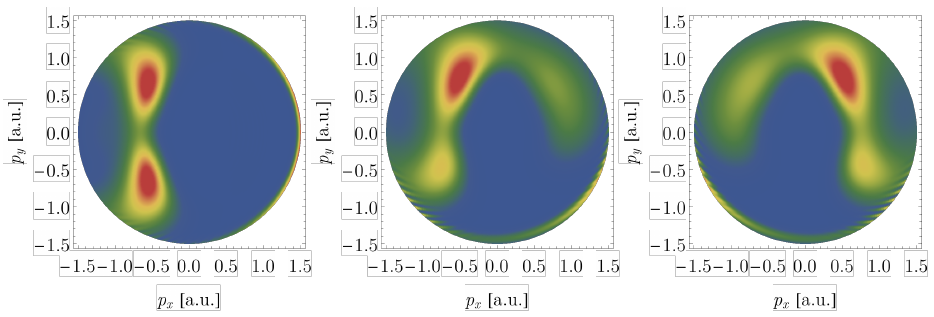
Figure 7. Photoelectron momentum distributions in the polarization plane ( ϑ p = π /2) for a krypton target. Momentum distributions are shown for circularly-polarized laser beams with three different CEP phases: φ ( CEP ) = 0 ◦ ( left panel ), φ ( CEP ) = 45 ◦ ( middle panel ) and φ ( CEP ) = 90 ◦ ( right panel ) and by applying a self-consistent initial 4 p orbital of neutral krypton together with a plane-wave Volkov continuum. All further laser parameters are the same as in Figure